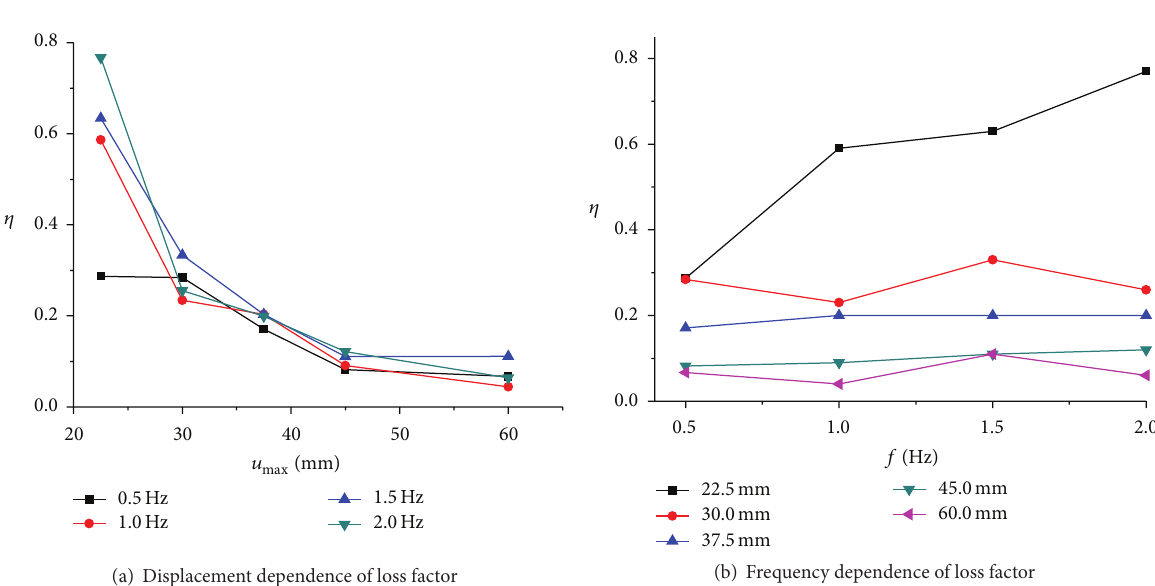
Figure 10: The shear loss modulus.